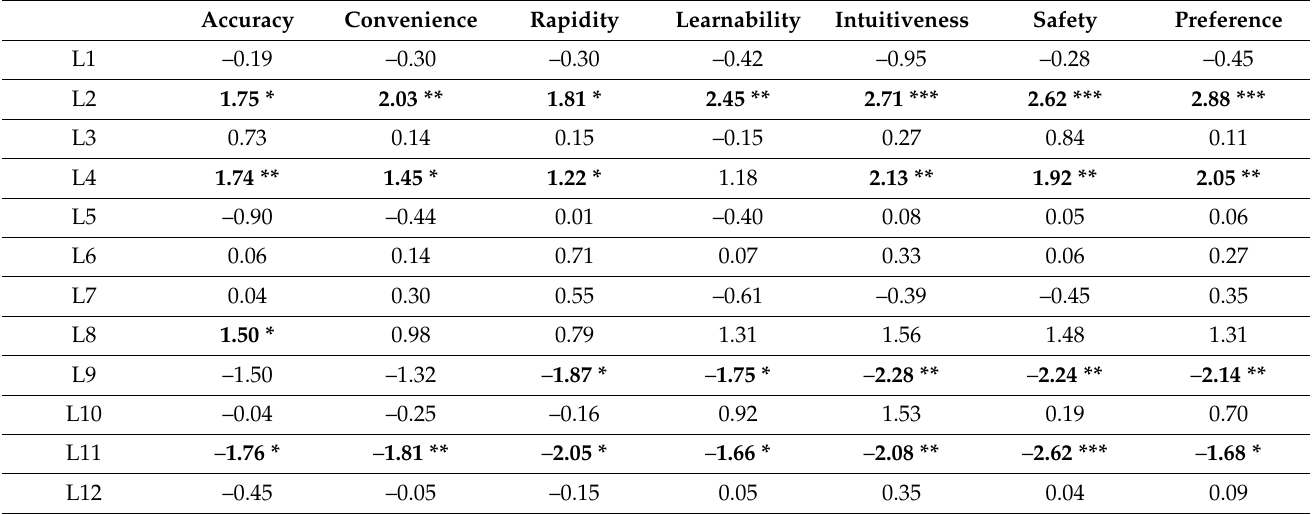
Table 7. Mean differences of seven dependent measures between the novice and experienced driver groups for each layout (Mean novice driver − Mean experienced driver ).